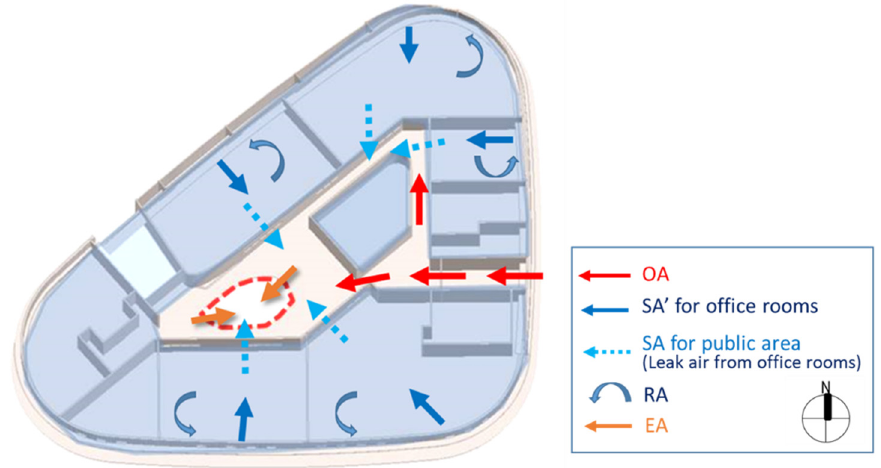
Figure 5. Predicted flow path in the studied building.